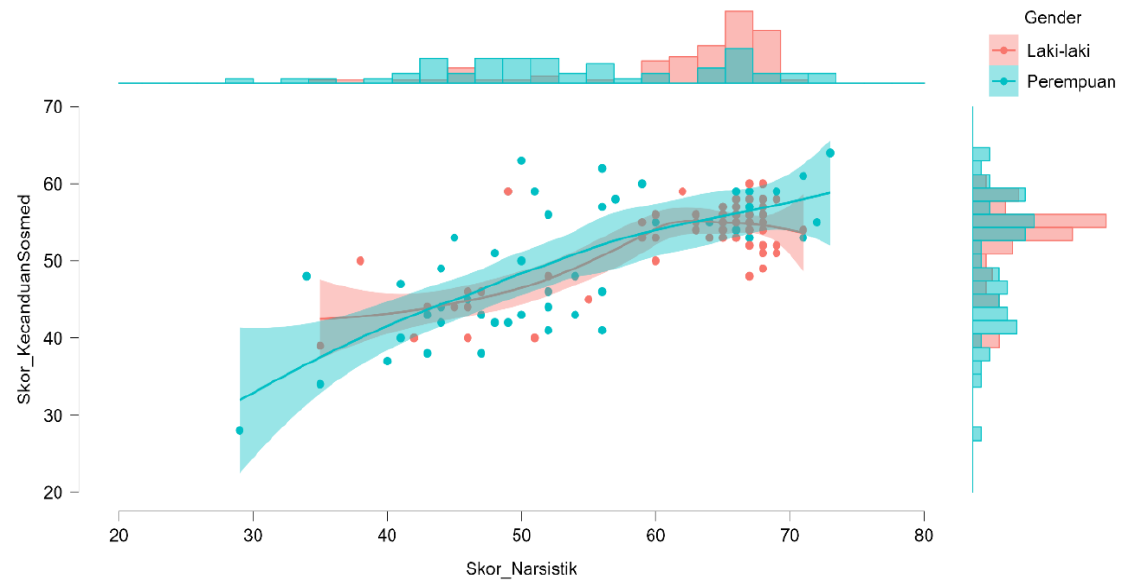
Figure 1. Narcissistic Scatter Plot and Social Media Addiction by Gender Based on the scatter plot, male students' narcissism and addiction to social media are higher than female students, as evidenced by the red histogram compared to blue. This condition strengthens the results from table 1 which explains that the average narcissistic and social media addiction of male students is higher than that of female